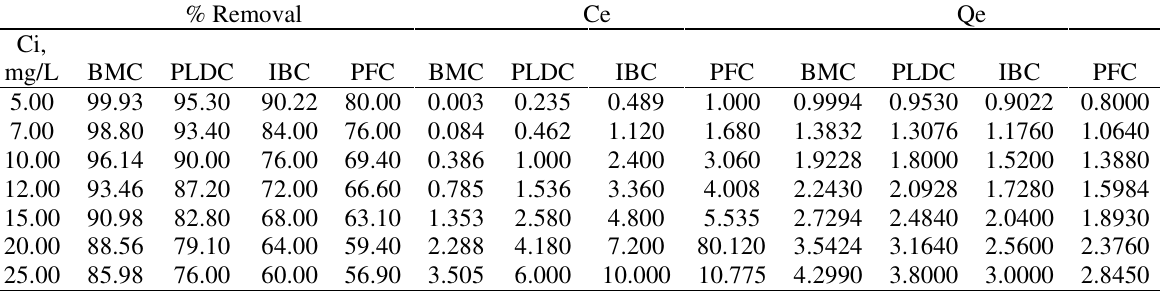
Table 1. Effect of adsorbate concentration on the percent removal of Mn(II) by adsorption with prepared ACs.